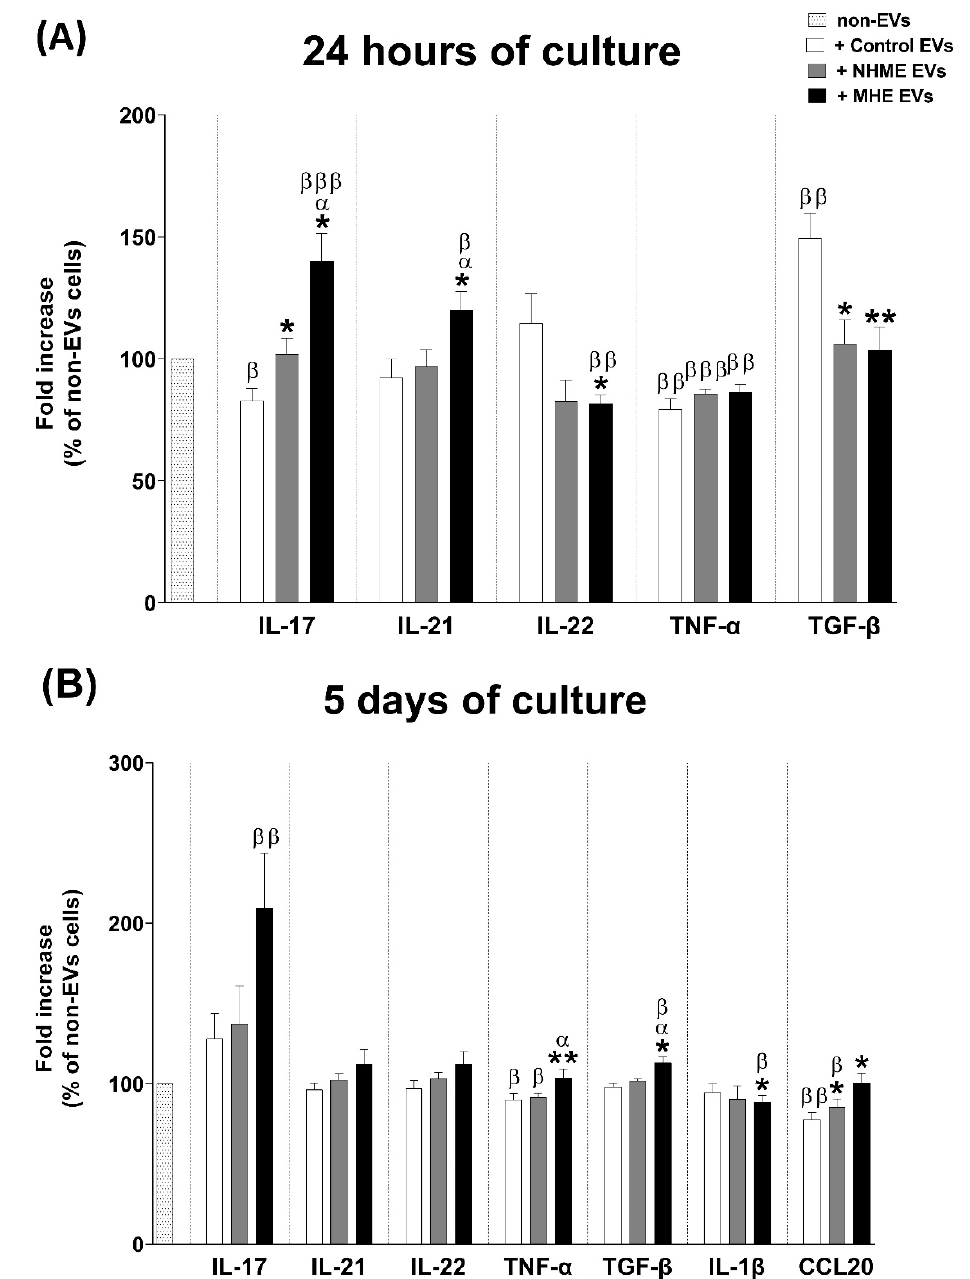
Figure 5. Cytokine release by CD4+ T cells after 24 h and 5 days cultured with human plasma EVs. ( A ) After 24 h of CD4+ T cells cultured with plasma EVs from the control (control EVs), without (NMHE EVs) or with minimal hepatic encephalopathy (MHE EVs) subjects, the levels of IL-17, IL-21, IL-22, TGF- β , and TNF- α were measured in the supernatant by ELISA. ( B ) Levels of IL-17, IL-21, IL-22, TGF- β , TNF- α , IL-1 β , and CCL20 measured after 5 days of culture. A condition without EV treatment was also included as a reference (non-EVS). Values are given as the fold increase of the cytokine levels over the non-EV condition, which was considered as 1. Values are the mean ± SEM. Eight independent experiments were conducted for all conditions. Values significantly different from the control EV condition are indicated by asterisks (*), from the NMHE EV condition by α , and from the non-EV condition by β (*/ α / β : p < 0.05; **/ ββ : p < 0.01; βββ : p < 0.001).